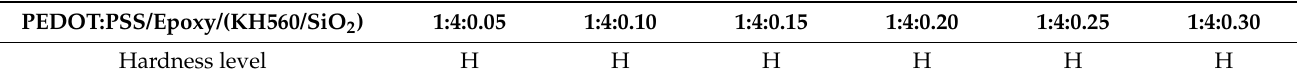
Table 2. The pencil hardness properties of PEDOT:PSS/epoxy/(KH560/SiO 2 ) coatings under differ- ent P:E:K